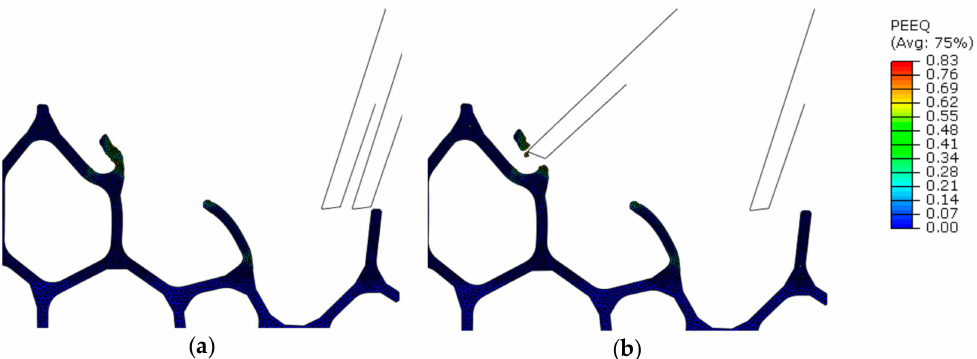
Figure 12. Plastic equivalent strain distribution in the region surrounding the tool path in up milling (Model A, v c = 400 m / min, f z = 0.03 mm): after 1st sweep ( a ) during 2nd sweep ( b